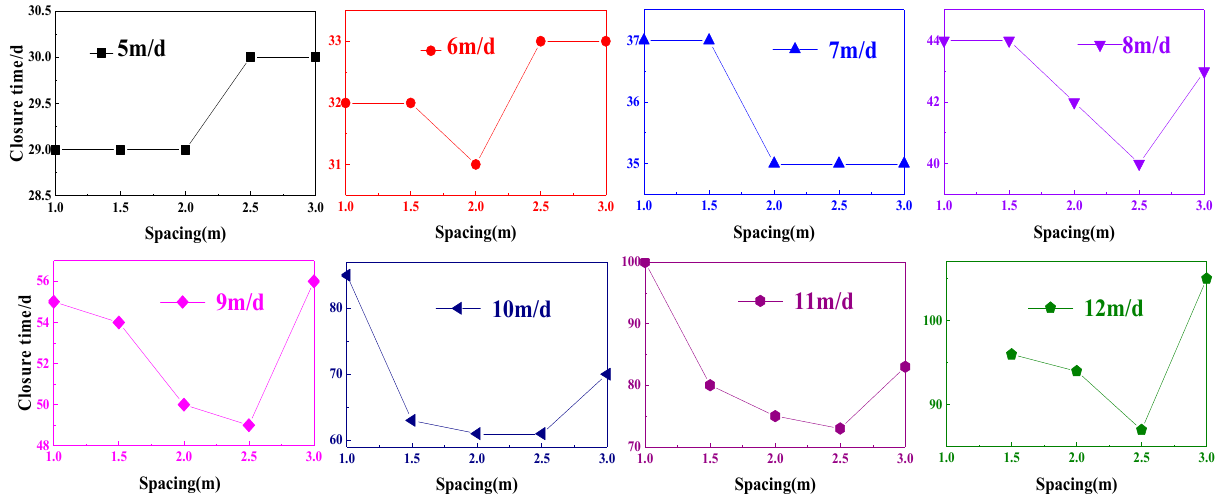
Figure 13. Influence law of auxiliary freezing holes spacing L on closure time under different groundwater velocities.